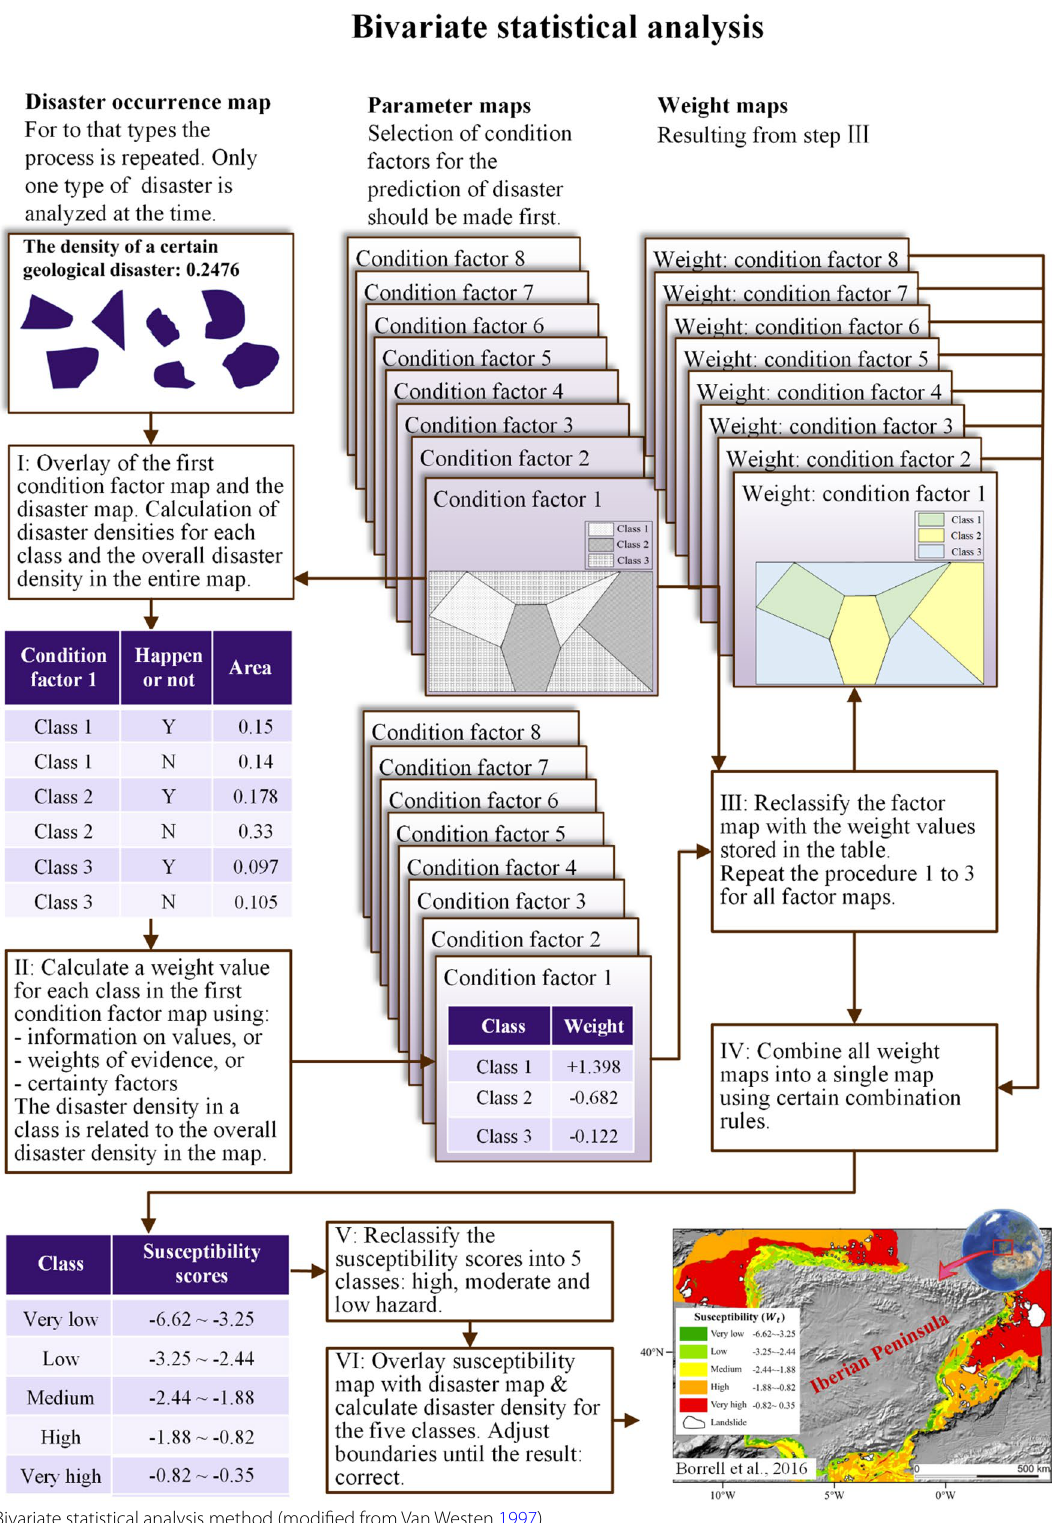
Fig. 6 Bivariate statistical analysis method (modified from Van Westen